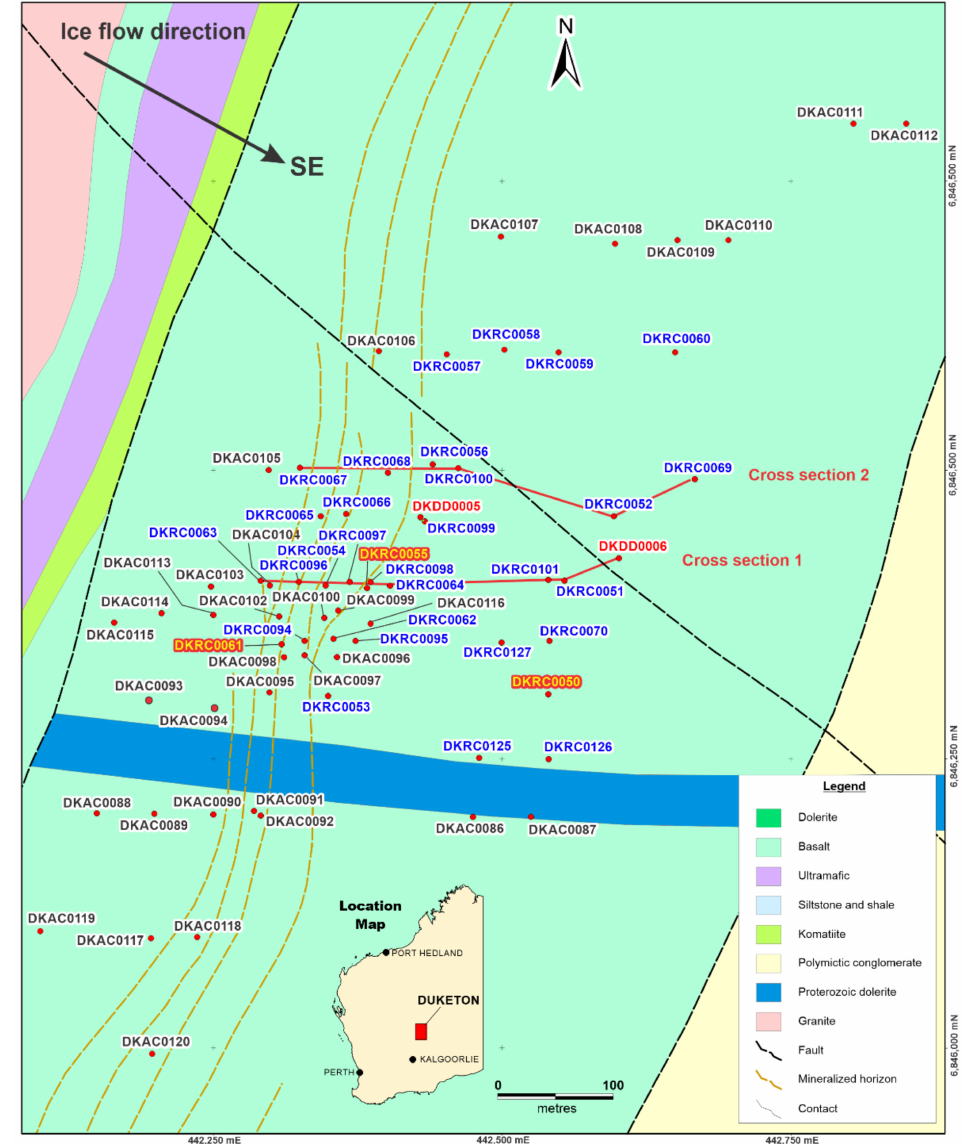
Figure 2. A geological map showing the main Archean rock units, faults, and mineralized horizon and the locations of RC (blue color), diamond (red color), and AC (black) drill holes. Black arrows show the ice flow direction. The three holes highlighted in red are selected for chemical analyses (Figure